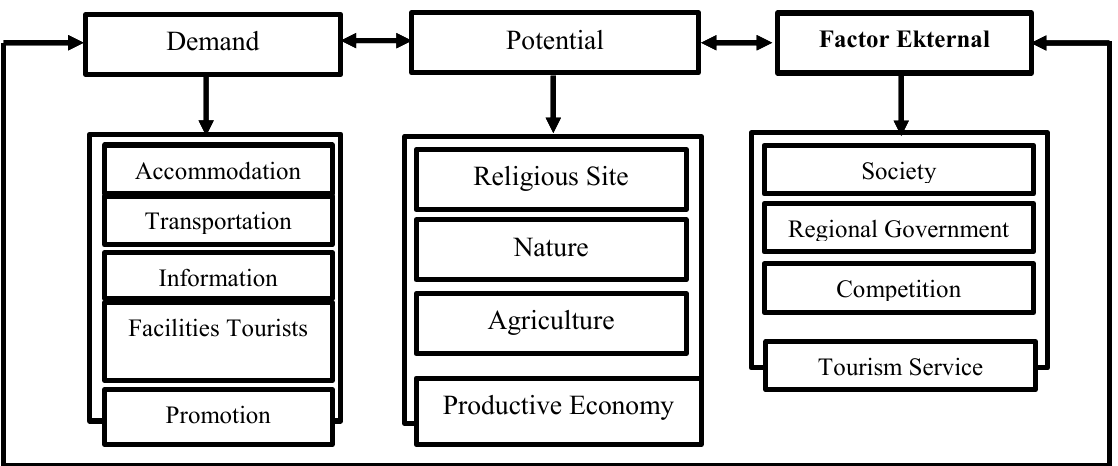
Figure 3. Religious Tourism Model in Banyuwangi Regency Source: Primary Data